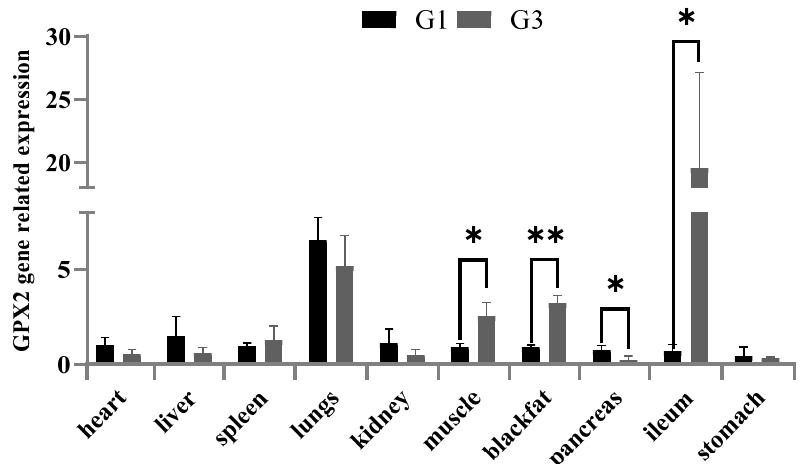
Figure 3. mRNA expression of GPX2 in different tissues for combination genotype G1 and G3 in Duroc pigs. combination genotype G1: GG-TT-CC-TT-CC-GG-GG, combination genotype G3: AA-CC-TT-GG-TT-AA-CC. * indicates p < 0.05, ** indicates p < 0.01.